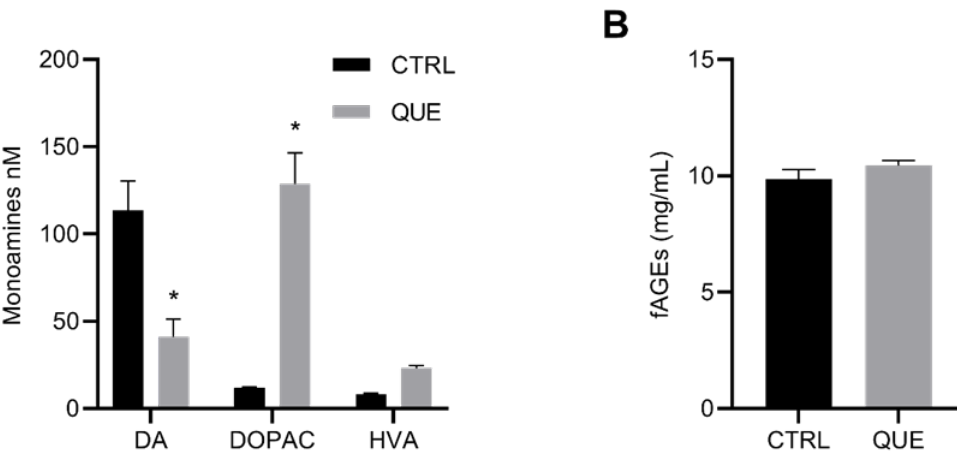
Figure A2. Diet supplemented with QUE decreases dopamine concentration and increases the oxidized metabolite DOPAC. Brain extracts without (CTRL) and after 4.80 mM QUE feeding for 24 h were collected at 09:00 and measured in triplicate ( n = 9). ( A ) Using high performance liquid chromatography active form of dopamine (DA), 3,4-dihydroxyphenylacetic acid (DOPAC) and homovanillic acid (HVA). *: p < 0.05, two-way ANOVA with Tukey’s multiple comparison post-hoc test. ( B ) Fluorescent advanced end glycation products (fAGEs) concentration determined using calibration curve for standard calibrator fAGEs-BSA (bovine serum albumin). Statistical analysis was done using unpaired t -test.